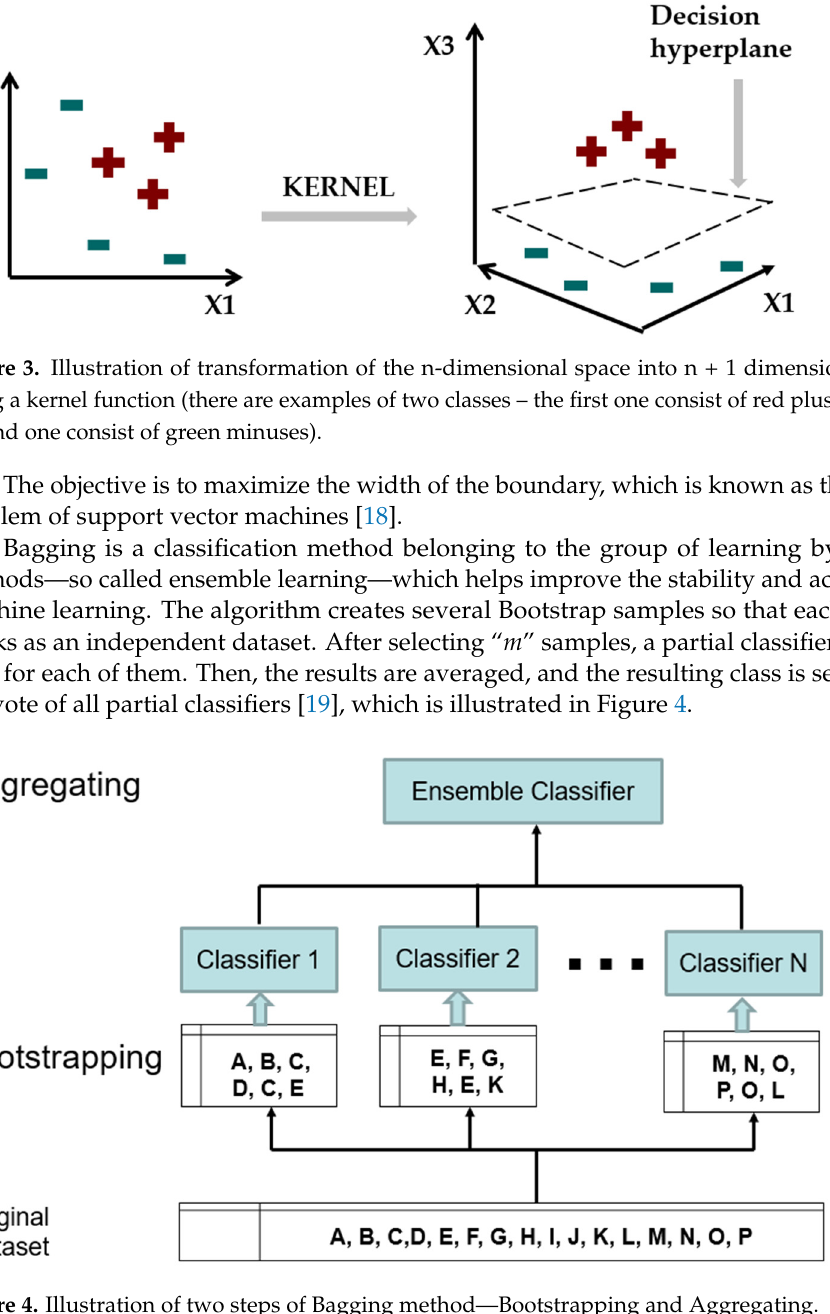
Figure 4. Illustration of two steps of Bagging method—Bootstrapping and Aggregating.